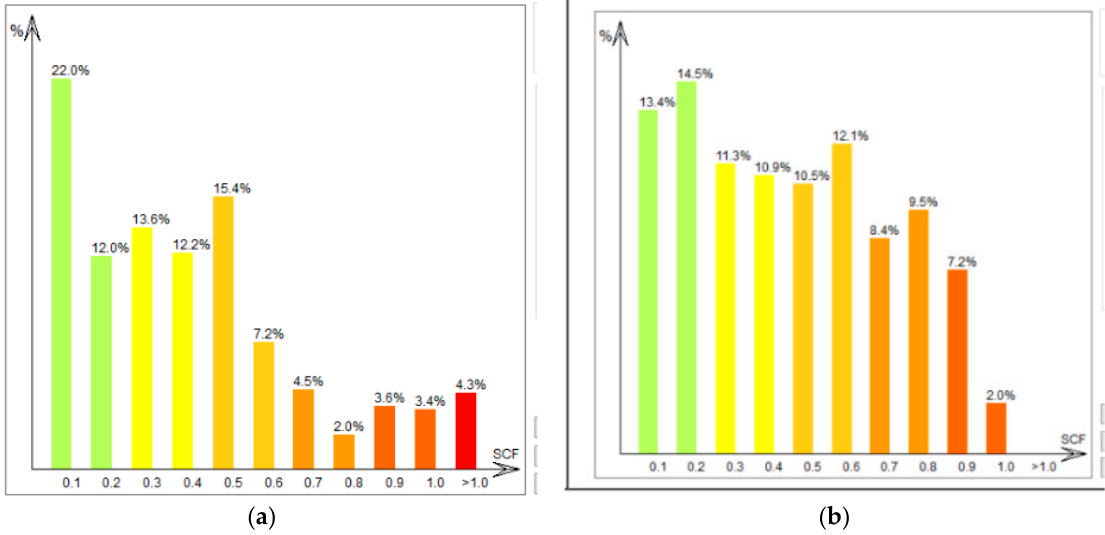
Figure 9. Utilizations of Steel Members. ( a ) Before optimization; ( b ) After optimization.